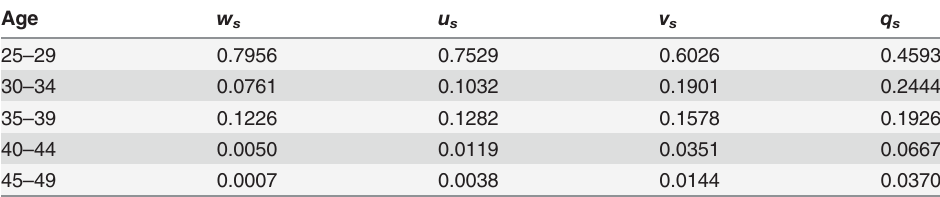
Table 2. Weighting systems used for the analysis of the data in Table